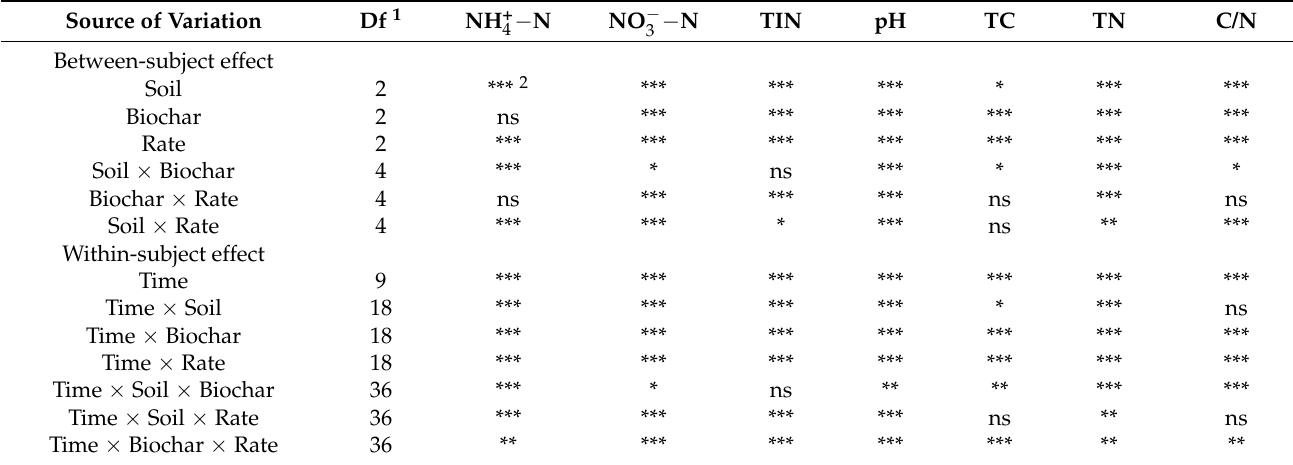
Table 1. Significance ( p value) of repeated measures MANOVA results for selected soil parameters under different woody biochars (Biochar), soil types (Soil) and biochar application rates (Rate) after 400 days of N incubation 1 . − Source of Variation Df 1 NH + 4